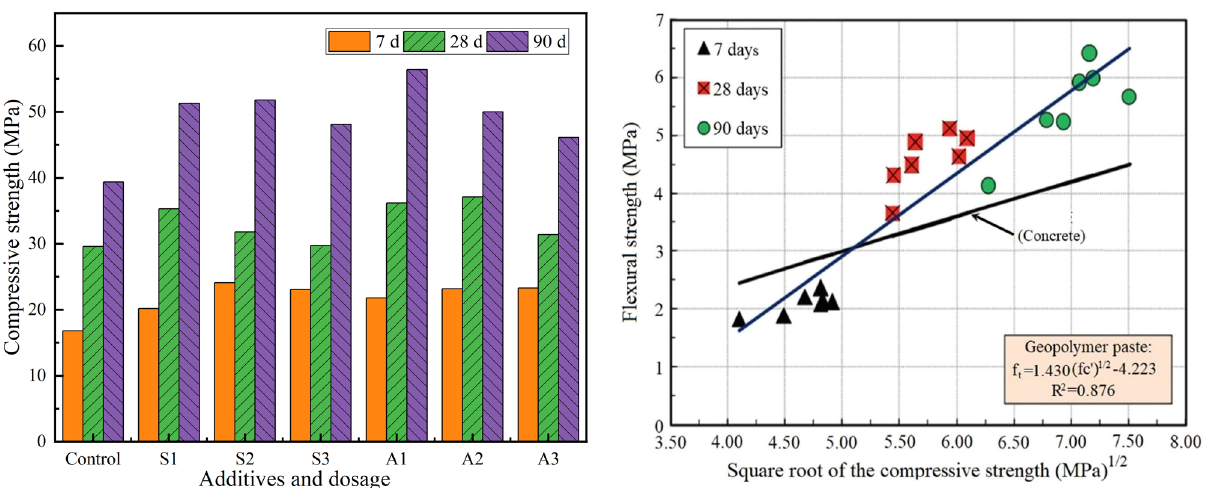
Figure 4: Compressive strength of geopolymer pastes [ 41 ] .